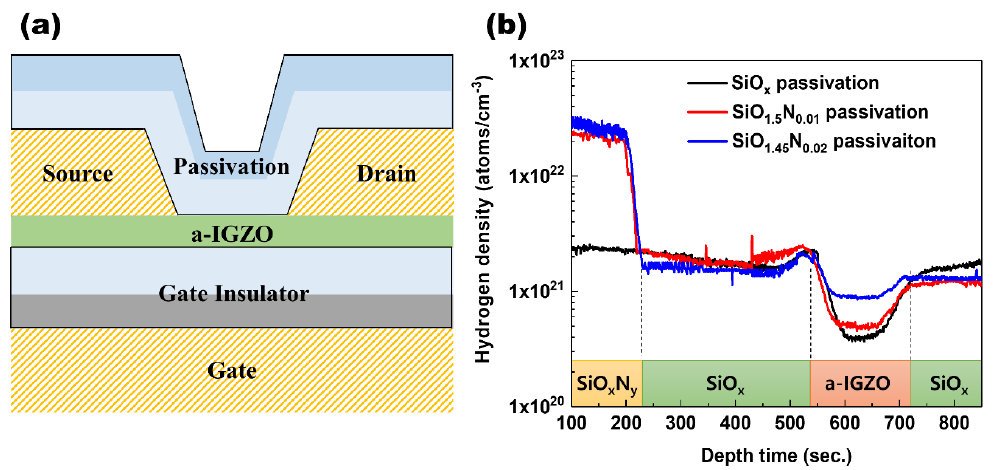
Figure 1. ( a ) Cross-sectional schematic of the bottom-gate inverted staggered structure of a-InGaZnO TFT. ( b